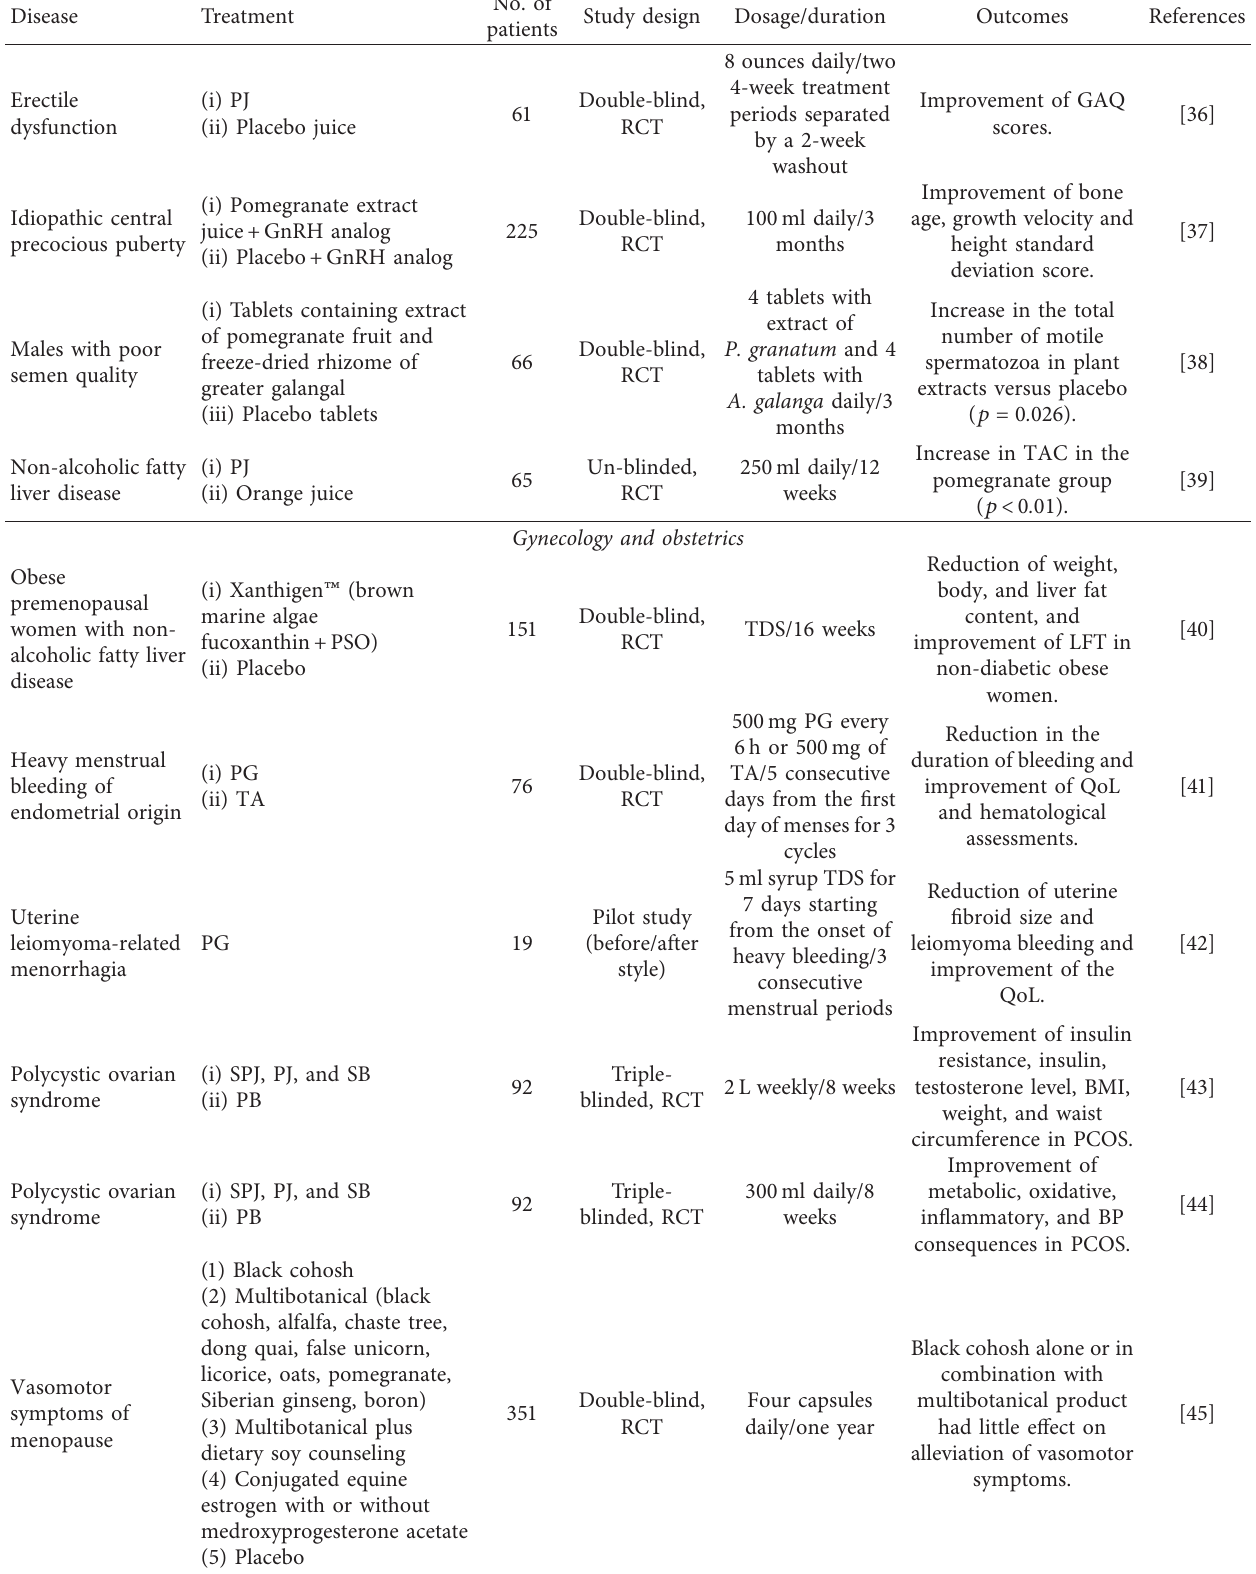
Table 1: Summary of clinical trials using Punica granatum (pomegranate) in endocrine disorders.